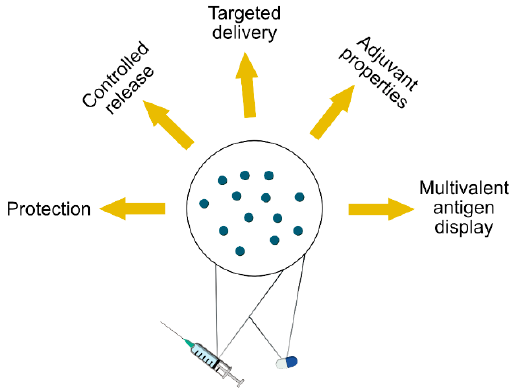
Figure 1. Benefits of encapsulating drugs into particles.